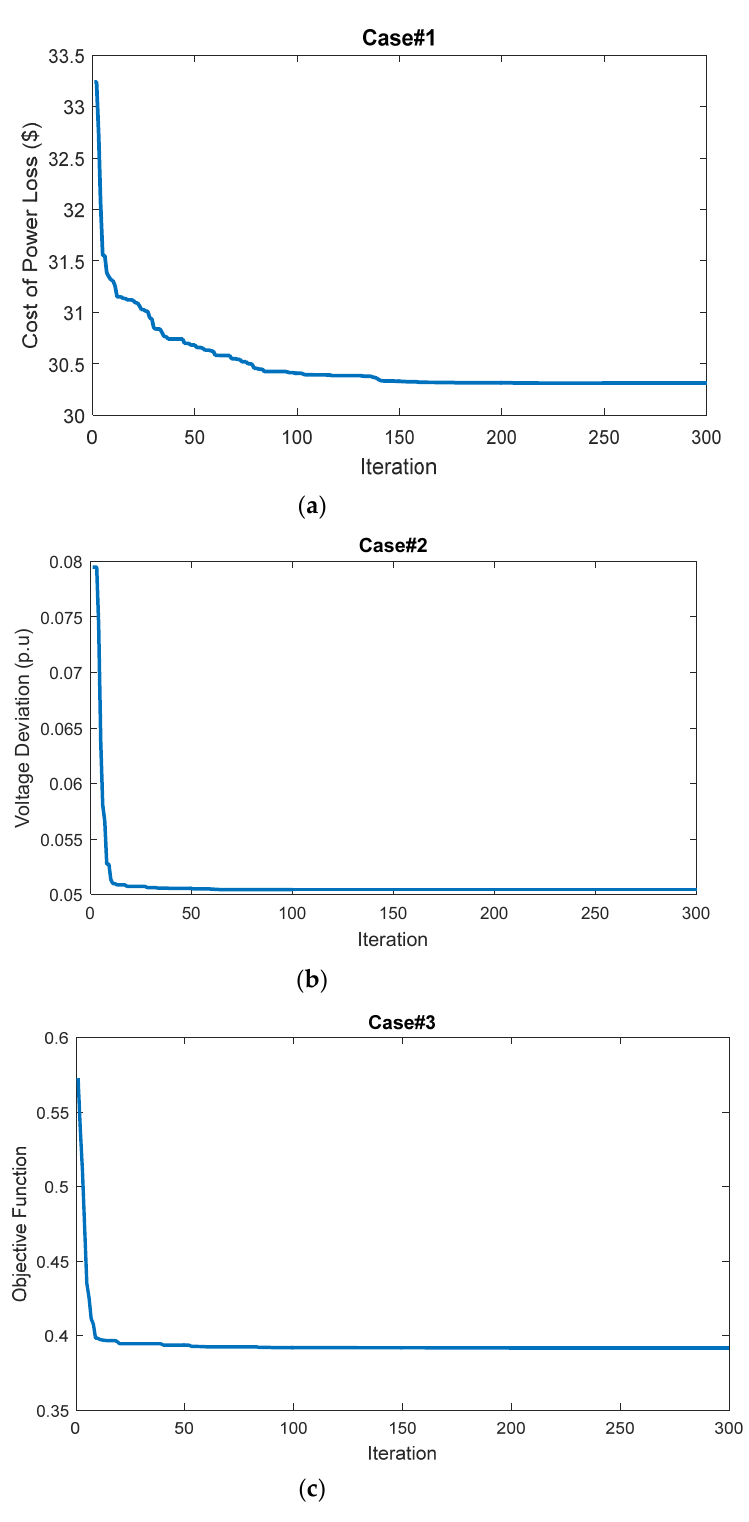
Figure 9. Convergence curve of the AOA in the OSPF solving ( a ) Case#1, ( b ) Case#2, and ( c ) Case#3. The optimal size and location of wind turbines and also the PHEVs are given in Tables 2 and 3, respectively. The AOA determines two turbines for cases 1 and 2 and also three turbines for case 3. Moreover, the AOA considers seven parking lots for case 1 and also four parking lots for cases 2 and 3.